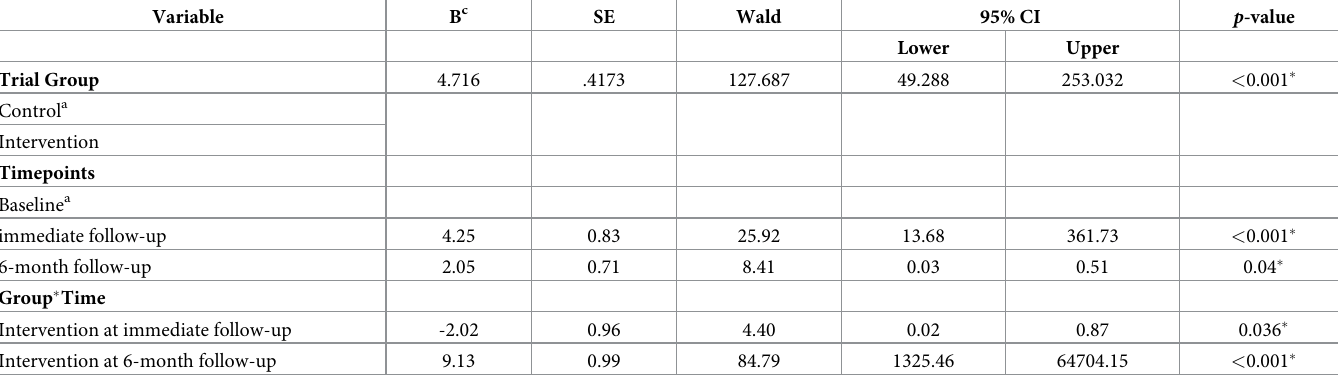
Table 5. Effectiveness of HEBI on Skill between intervention and control group.